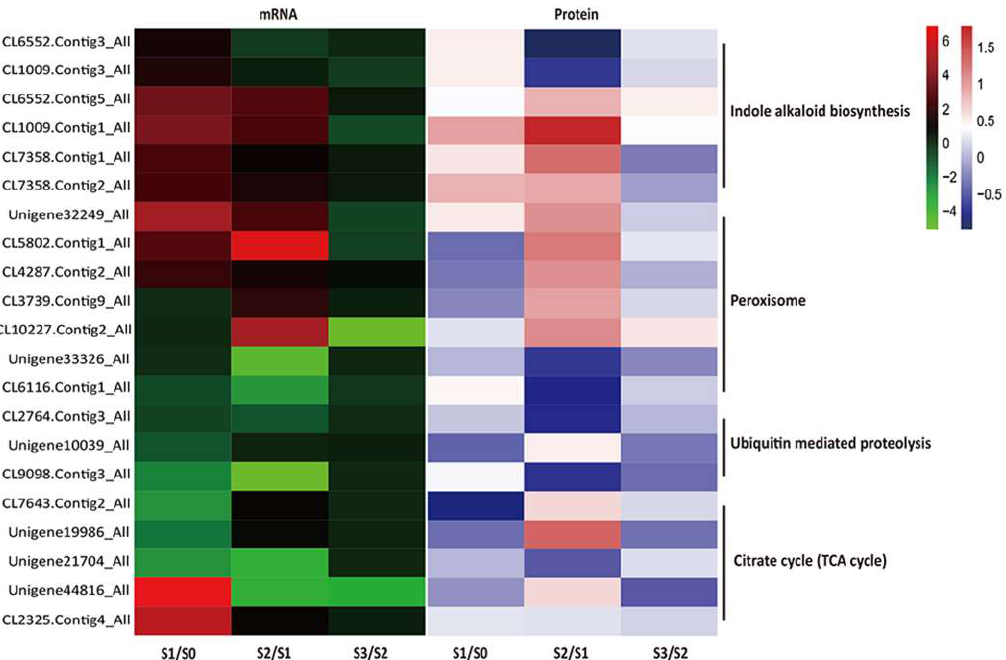
Figure 8. Analysis of differentially abundant proteins and genes in relevant pathways. Red color indicates an increase; green and blue color indicate decreases. The relative changes in abundance (S1/S0, S2/S1 and S3/S2) are shown using a log2 scale.